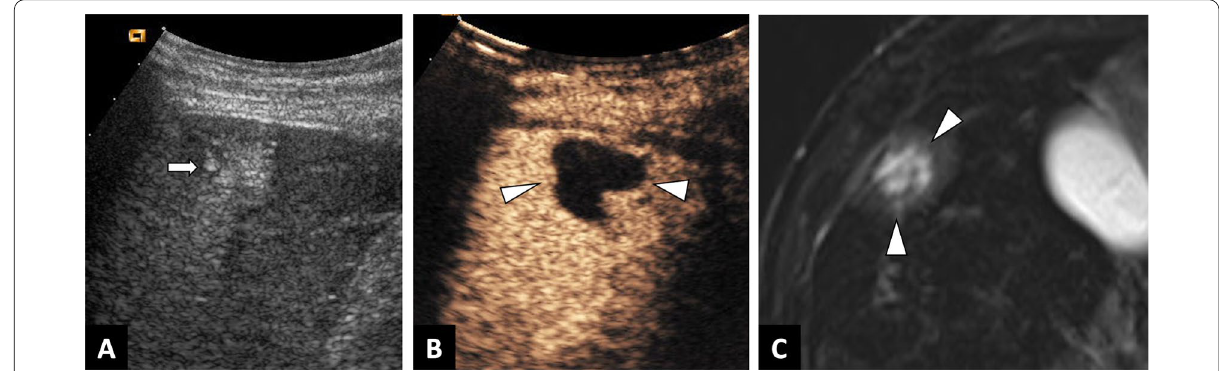
Fig. 4 Incidental alveolar echinococcosis discovered in a 65‑year‑old man with a recent history of acute myeloid leukemia, and presenting with liver blood test abnormalities. A. Abdominal ultrasound showing heterogeneous echogenic mass with irregular borders. B. Contrast‑enhanced ultrasound showing the absence of enhancement of the liver lesion (arrowheads). C. T2‑weighted MR images in the axial plane showing pathognomonic microcysts